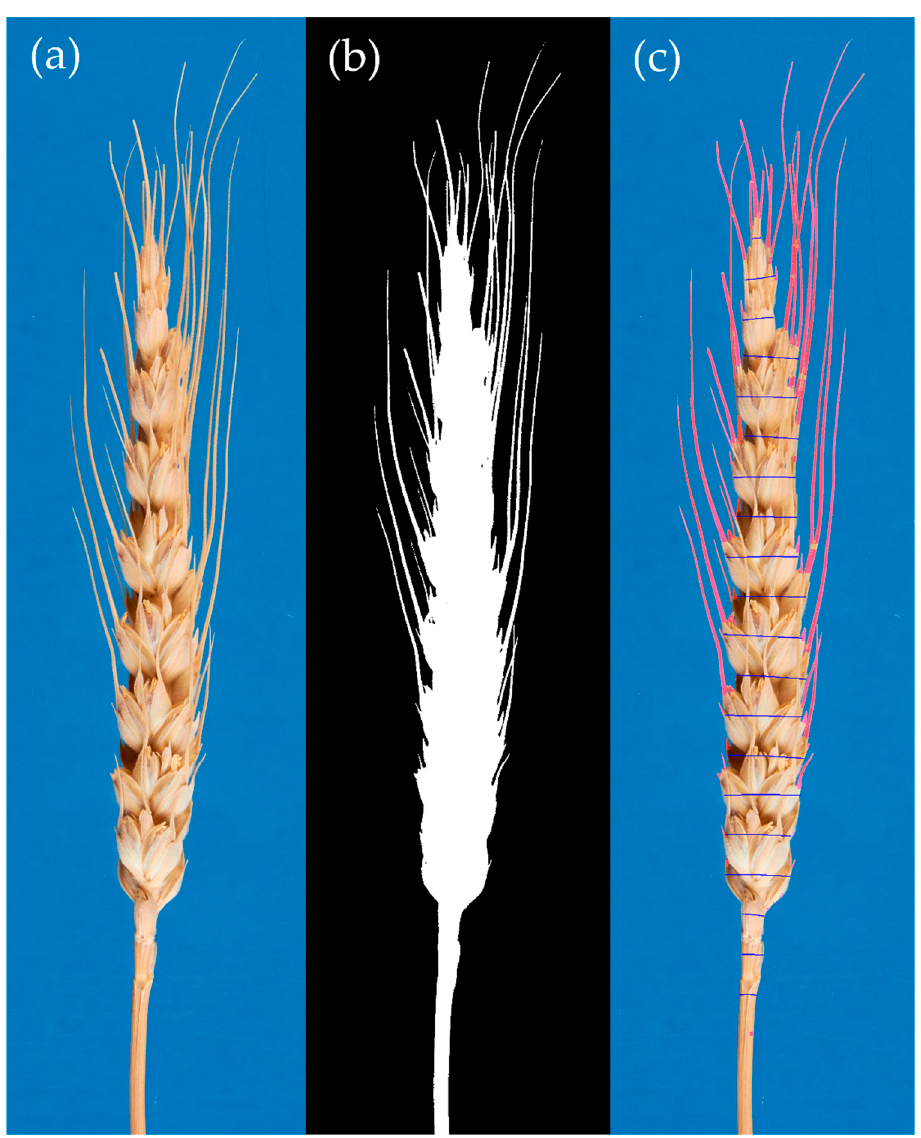
Figure 4. Stages of the algorithm for identifying awns by the example of a spike of F 2 hybrid between the Triple Dirk B and Chinese wheat T. yunnanense ID no. 6450: ( a ) Spike image on blue background; ( b ) binarized spike pattern; and ( c ) initial spike image with recognized awn regions (marked red) and spike sections (marked blue).